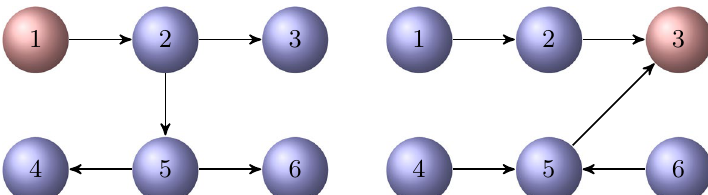
Fig. 4 An out-tree T 1 out with root v 1 for the graph G in Fig. 3, and an in-tree T 3 in rooted at v 3